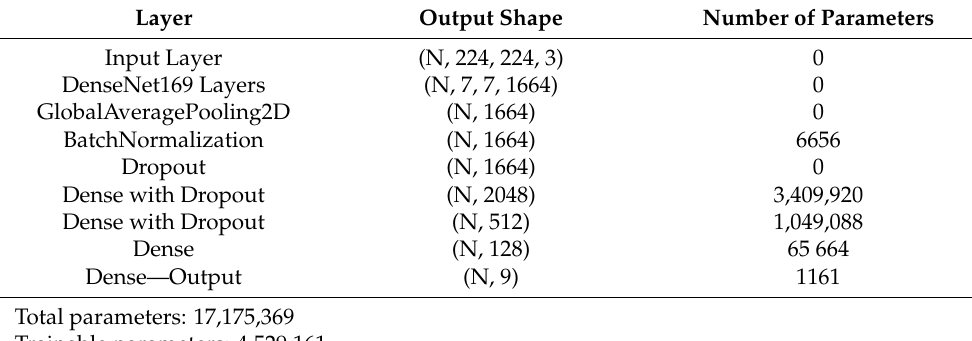
Table 7. Summary of the custom layers added to the pre-trained DenseNet